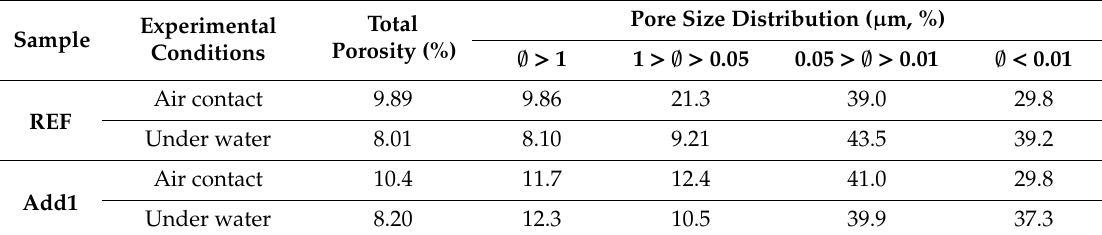
Table 5. Total porosity and pore size distribution (%) of the concrete samples after 90 days.